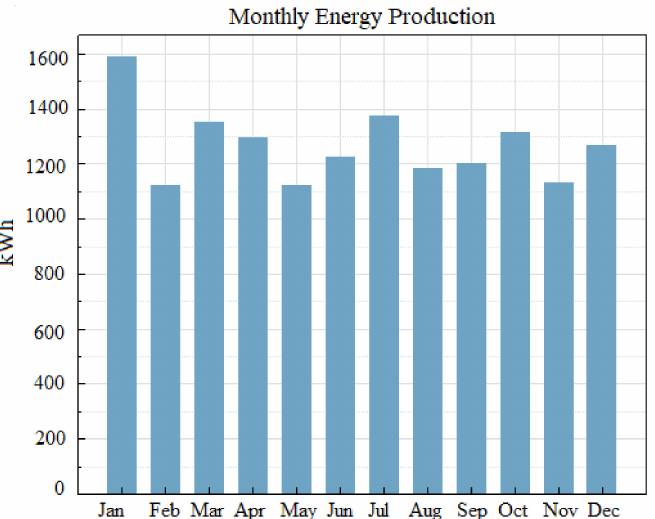
Figure 13. The monthly energy production system of tilt angle = 23 ◦ and azimuth angle = 11 ◦ .